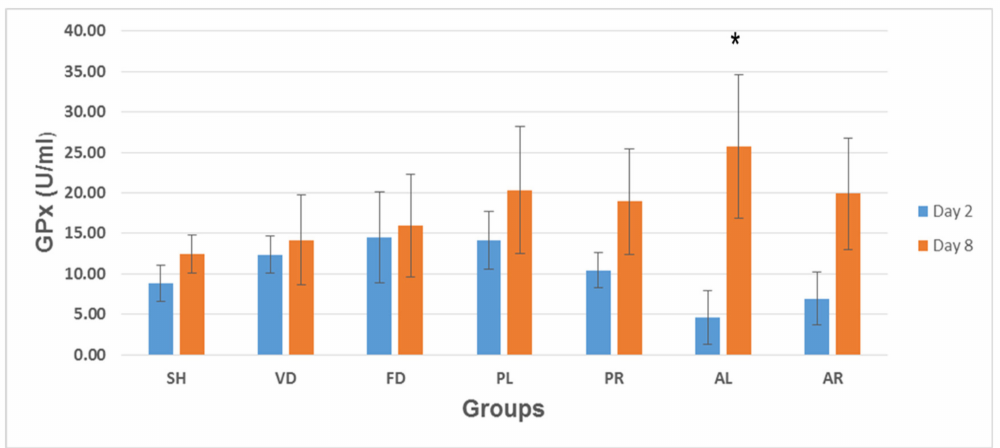
Figure 9. Glutathione peroxidase (GPx) levels in skin tissue of seven rat experimental groups: SH, VD, FD, PL, PR, AL, and AR. All data are given as mean ± S.E. for six animals in each group. Statistically significant results indicated as (*) p < 0.05 versus control groups (SH, VD, and FD) on the corresponding day. SH: sham control group (without treatment); VD: treated with vehicle (Cetomacrogol ointment); FD: treated with flavine (Acriflavine 0.1%); PL: treated with 1.0% concentration of MPvp leaves extract; PR: treated with 1.0% concentration of MPvp stem-roots extract; AL: treated with 2.0% concentration of MPva leaves extract; AR: treated with 2.0% concentration of MPva stem-roots